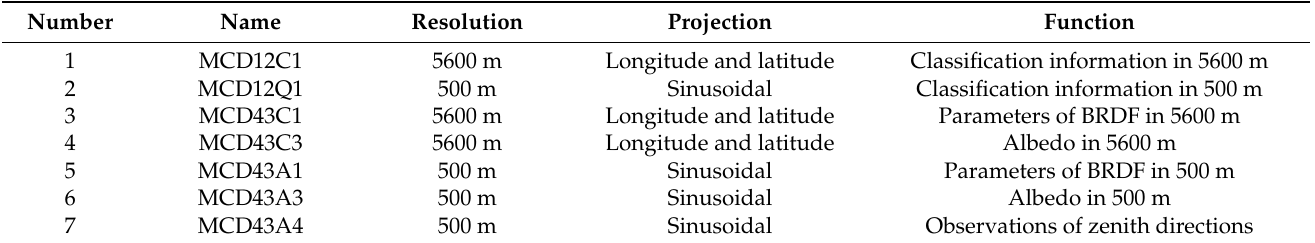
Table 2. Statistics of MODIS data